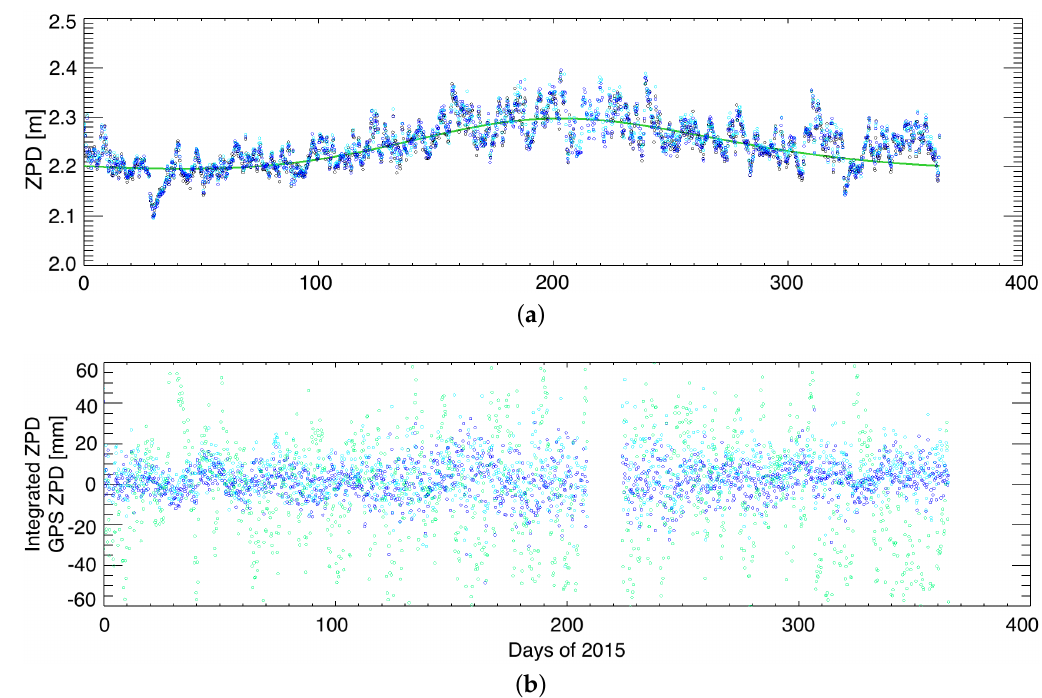
Figure 2. Time-series analysis of integrated and approximated ZPD during 2015 at each analysis time (0, 6, 12 and 18 h UTC) compared to GPS ZPD at the Wettzell station. ( a ) Absolute ZPD: integrated using ERA-Interim (cyan) and OP (blue), empirical from GPT2w model (green) and GPS (black). ( b ) Difference between integrated and empirical ZPDs and GPS ZPD with same color